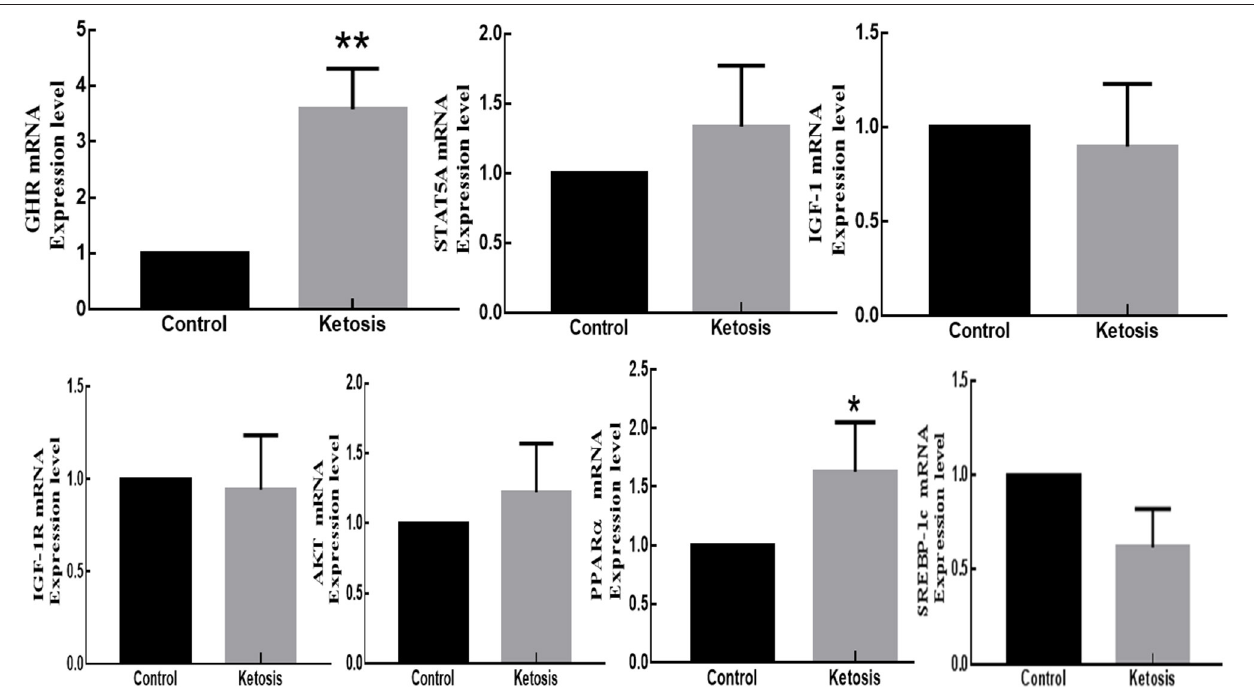
FIGURE 5 | The mRNA expression of GHR, JAK2-STAT5A, IGF-1, IGF-1R, PI3K-AKT, SREBP-1C, and PPAR α genes in adipose tissue of SCK and CON dairy healthy cows during 0 to 7 weeks of postpartum. *Denotes the difference is significant at p < 0.05; **denotes the difference is highly significant at p <